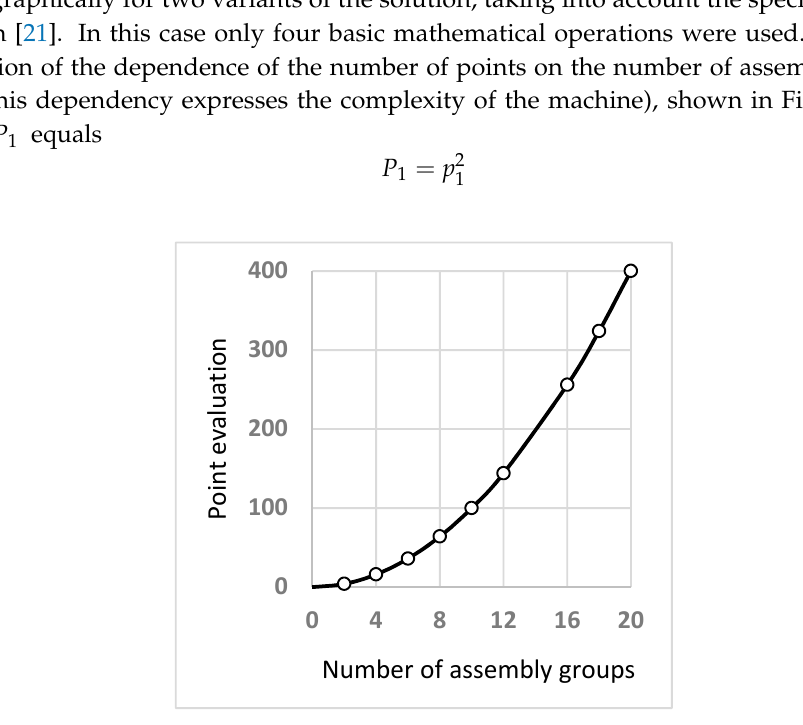
Figure 3. Dependence of the number of points on the number of assembly groups. Source: authors.